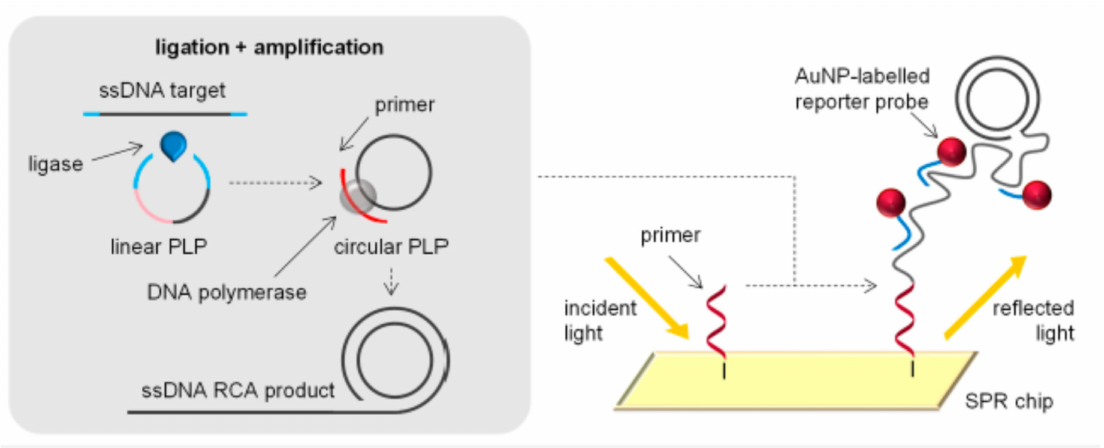
Figure 23. Schematic illustration of an optical aptasensor based on Rolling circle amplification (RCA). Reprinted from [141]. This article is an open access article distributed under the terms and conditions of the Creative Commons Attribution (CC BY) license (https://creativecommons.org/licenses/by/4.0/ 25 March